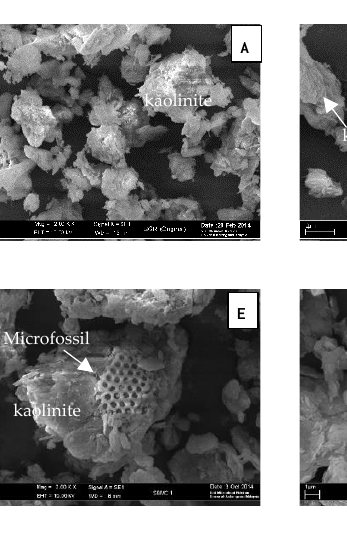
Figure 3. SEM images of granitic residual soil on ( A ) BGR at 2000×, ( B ) BGR at 5000×, ( C ) KGR at 2000×, ( D ) KGR at 5000×, and marine clay on ( E ) SBMC1 at 2000×, ( F ) SBMC1 at 5000×, ( G ) SBMC2 at 2000×, ( H ) SBMC2 at 5000×.